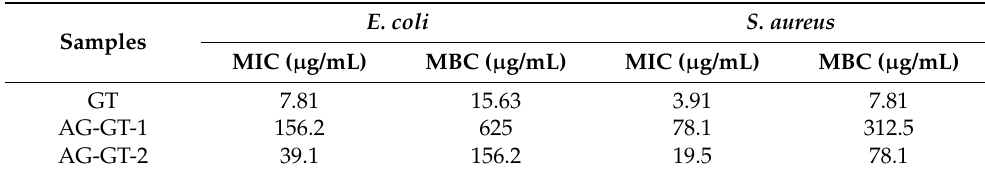
Table 3. Table 2 MIC and MBC of GT, AG-GT-1 and